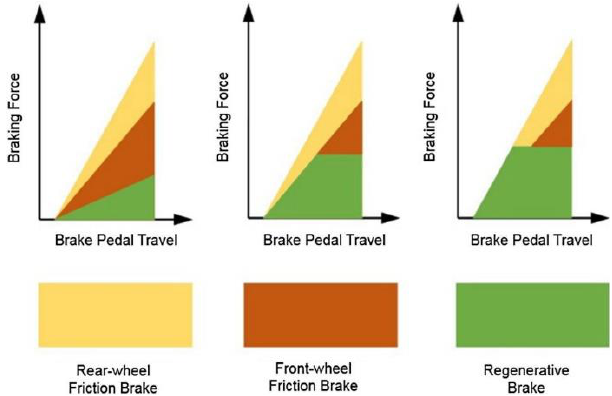
Fig. 4. Three different control strategies applied in regenerative braking process